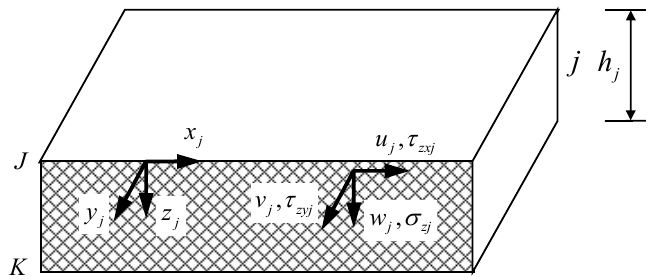
Figure 2. The local coordinates and the basic physical quantities of any constituent layer.